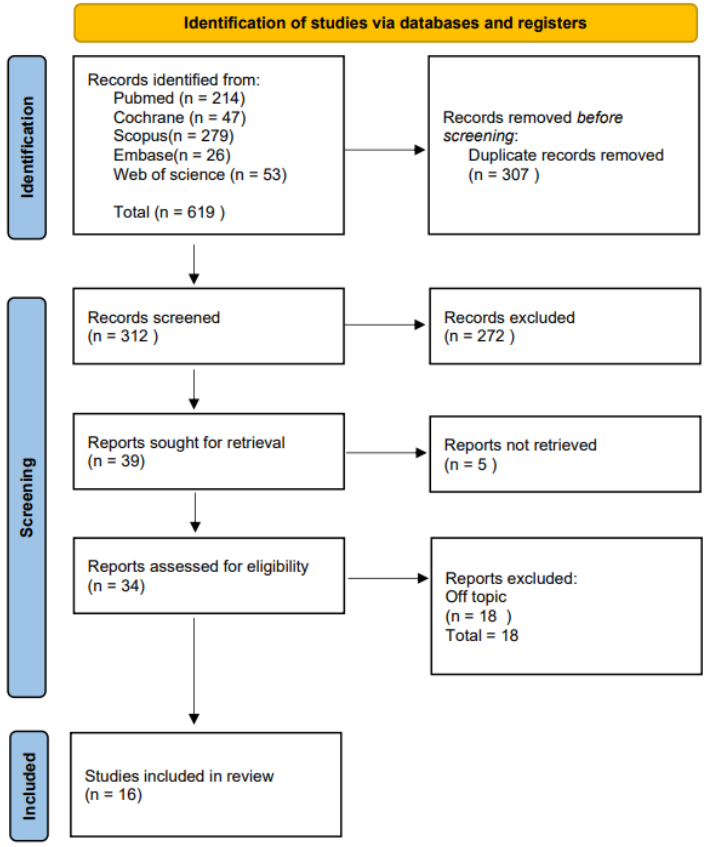
Figure 3. Literature search Preferred Reporting Items for Systematic Reviews and Meta-Analyses (PRISMA) flow diagram.